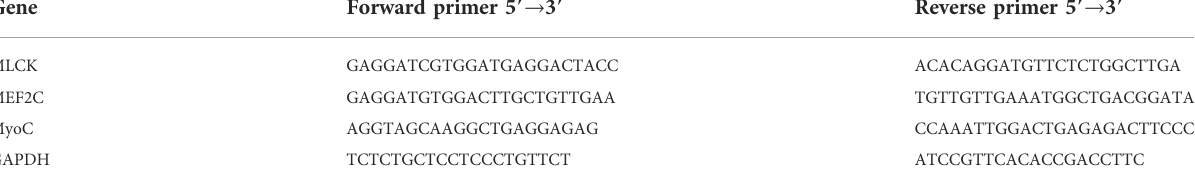
TABLE 1 The sequence of the primers used in the current investigation in RT-qPC.